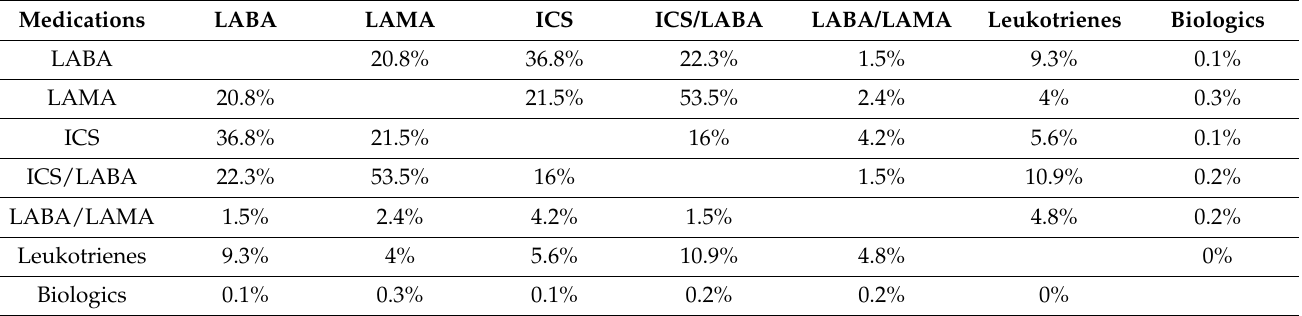
Table 5. The percentages represent the ratio of number of patients taking at least 3 packages of two drugs to the total number of patients.